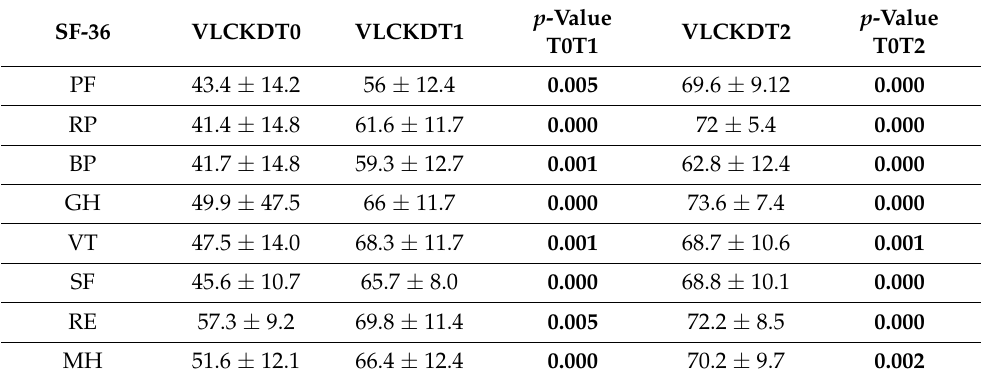
Table 5. Mean score ( ± SD) value of the 36-Item Short Form Health Survey questionnaire (SF-36) test at baseline, T1 and T2 in VLCKD group.